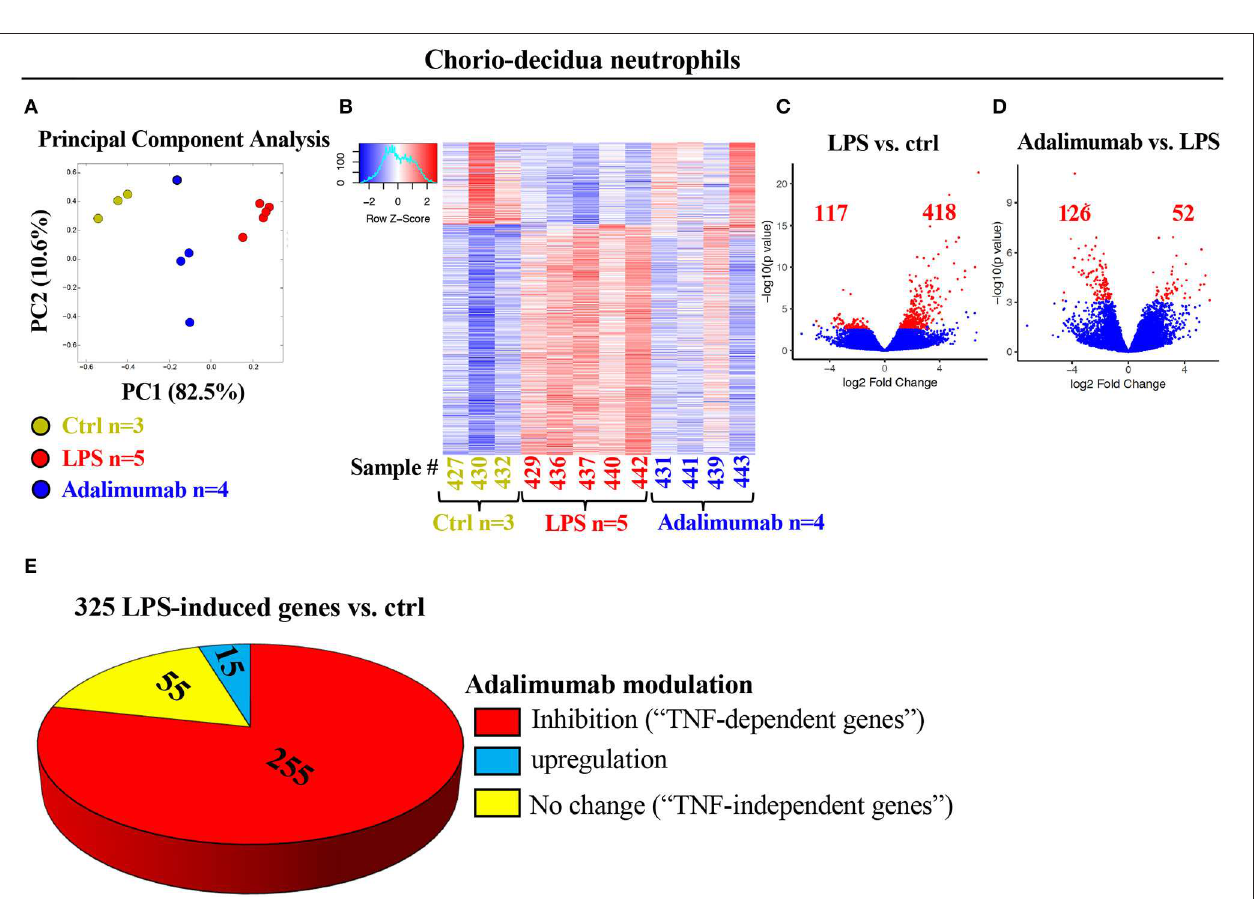
FIGURE 1 | predominance after LPS ( n = 19), while Adalimumab treatment ( n = 11) partially restored the profile toward controls ( n = 18). (B) Principal-component analysis (PCA) of RNA-seq profiling of neutrophils isolated from maternal blood using magnetic beads (open circles: Ctrl n = 3; LPS n = 5; Adalimumab n = 3) and from chorio-decidua by FACS (full circles: Ctrl n = 3; LPS n = 5; Adalimumab n = 4). The expression values were normalized across the entire datasets. (C) Heatmap of genes that are differentially expressed genes (DEGs, adjusted p < 0.05) between blood ( n = 3) and chorio-decidua neutrophils ( n = 3) in control animals only. (D) Biological processes of differentially expressed genes shown in (C) , as determined by Enrichr. Black bars represent upregulated biological processes and open bars represent downregulated biological processes in chorio-decidua neutrophils vs. blood neutrophils from control animals only. (E) Normalized counts of gene expression value of representative genes associated with the biological processes depicted in (D) . The lines show normalized counts of gene-expression trend plot from the same control animal (black line = sample #427, red line = sample #432, green line = sample #430; n = 3). * p < 0.05 (Unpaired t -test).